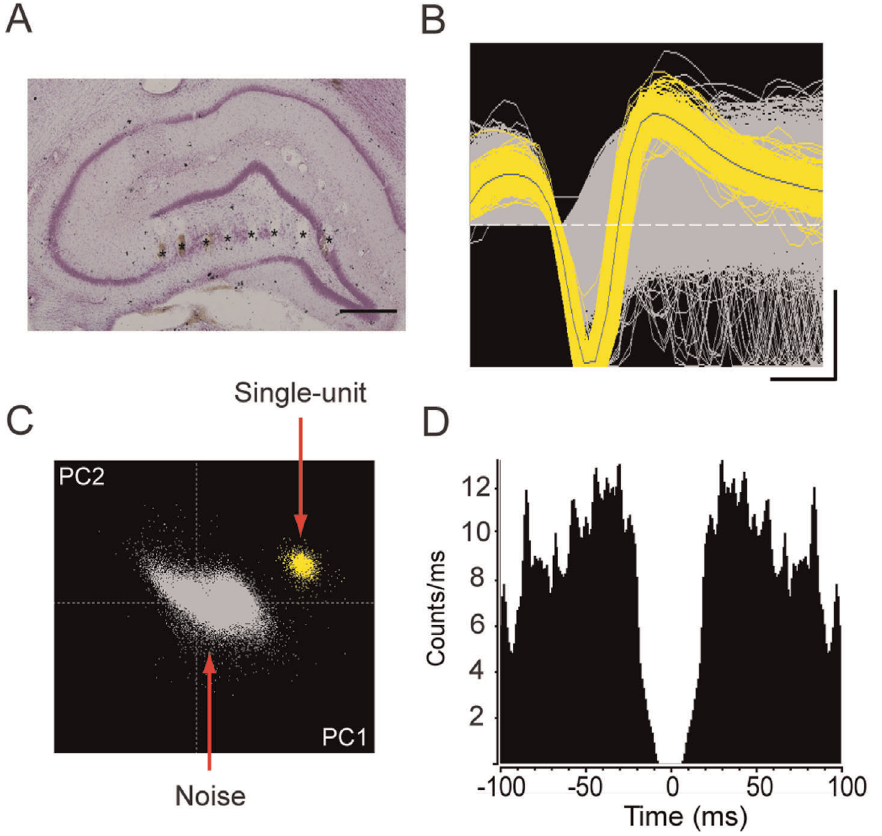
Figure 2. Recording and analysis profiles of neuronal ensembles. A . Histological locations (asterisks) of recording electrode tips in the hippocampus. Scale bar indicates 500 m m. B . Waveforms of hippocampal spikes (yellow) and noise signals (whitish-gray) separated by morphology (calibration: 0.2 ms, 100 m V). C . Clusters of single units and noise signals separated according to the first two principal components (PC1 on x-axis; PC2 on y-axis). D . Autocorrelogram of a single unit with an absolute refractory period of a minimum of 2 ms.